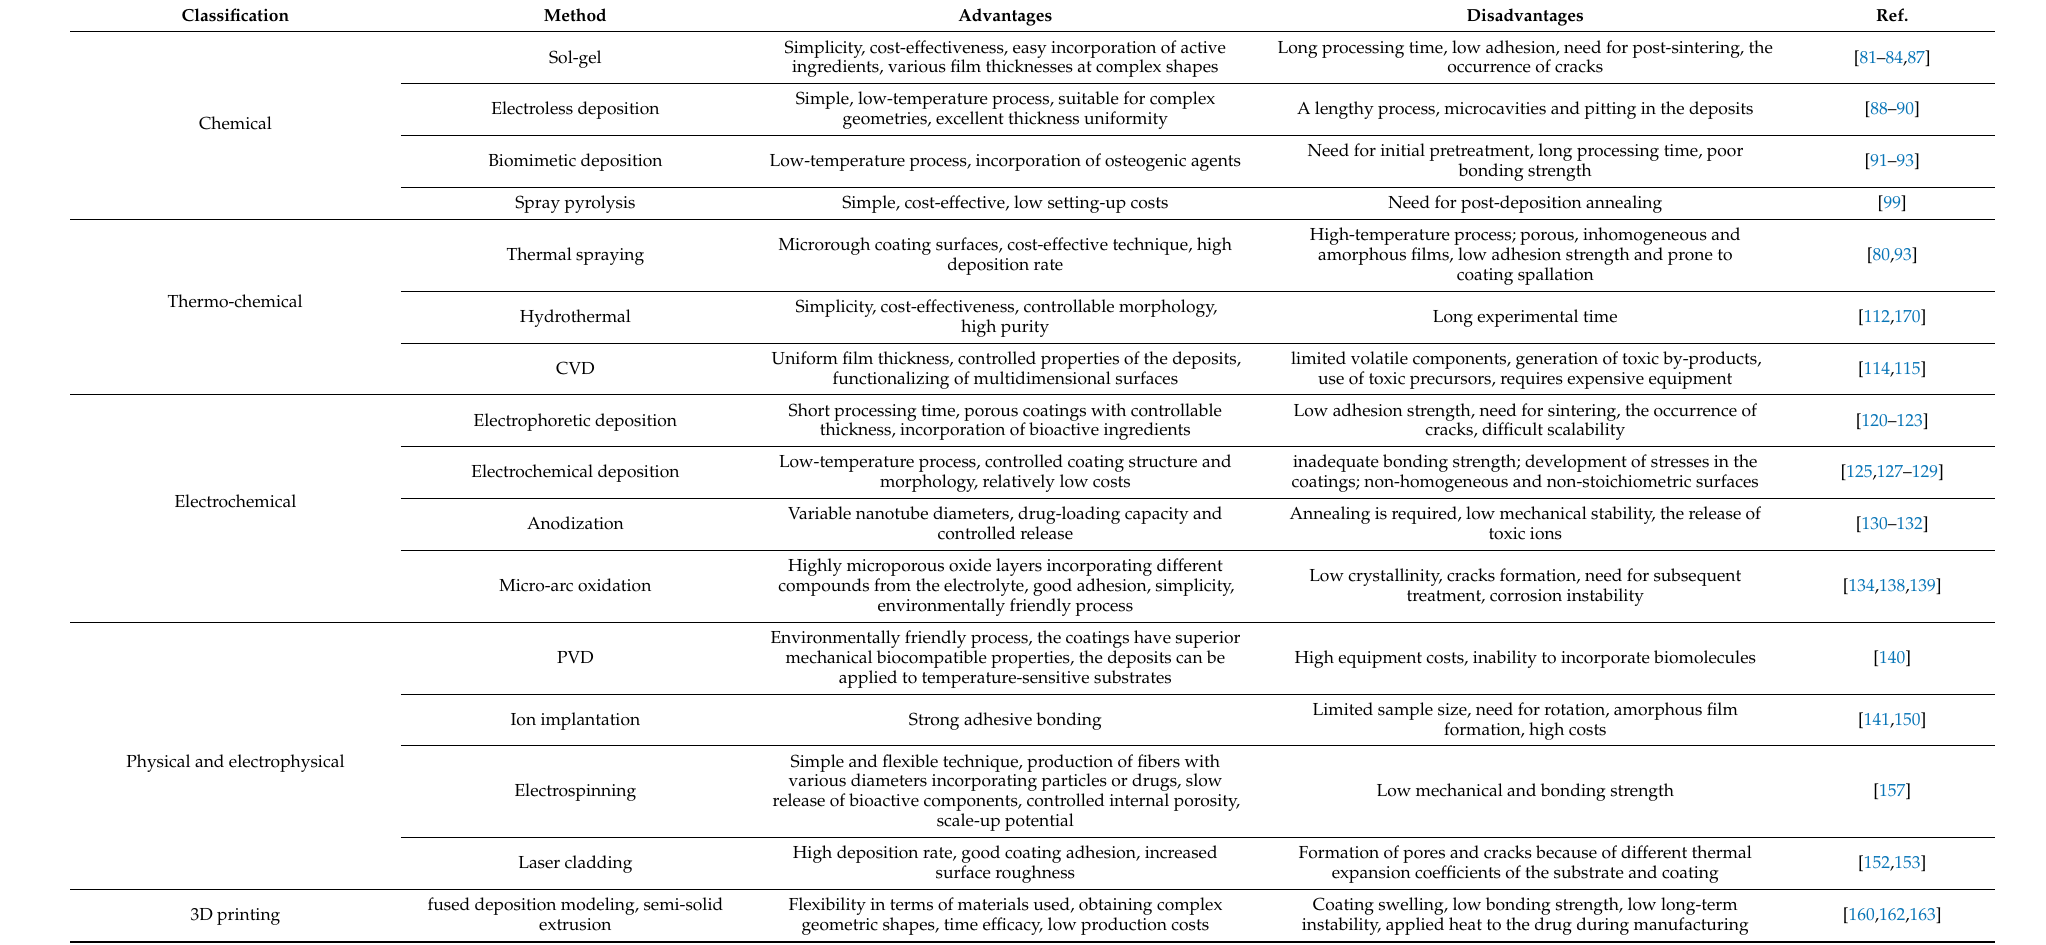
Table 1. Advantages and disadvantages of the coating methods used for deposition of bioactive coatings on metals and alloys developed for medical